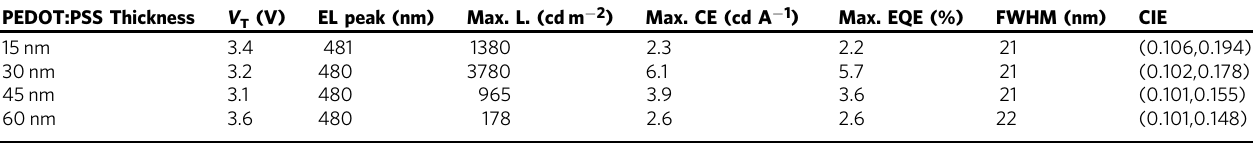
Table 2 Performance of perovskite LEDs (100% PEABr case) with different PEDOT:PSS thicknesses PEDOT:PSS